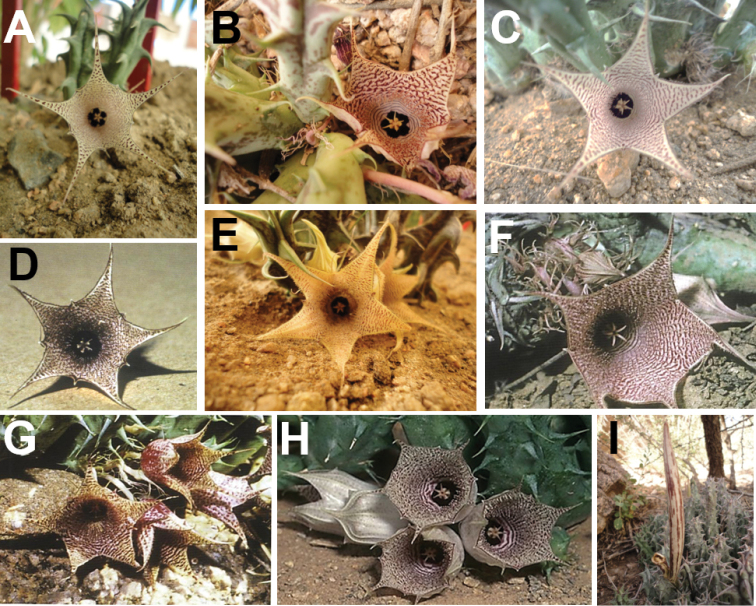
Ceropegia
khalidbinsultaniiAAlharbi S00 (H.
asirensis) BAlharbi S10b (H.
asirensis) CAlharbi S4a (H.
asirensis) DCollenette 5944, Jabal Radhwa, (H.
radhwana, Type) EAlharbi S16a (H.
asirensis) FCollenette 1309, Al-Baha, (H.
asirensis, Type) GCollenette 5970, Jabal Anagyan (H.
anagaynensis, Type) H ex Tom McCoy KSA129 sub DP8384, 25 km SW of Khamis Mushayt, (H.
khalidbinsultanii, Type) I follicles, Alharbi S14a. (A–C, E, I) photo by the first author from Wadi Thee Gazal, Ash Shafa; (D, F, G) reproduced from Plowes (2012)); (H) received from D. Plowes in 2011.